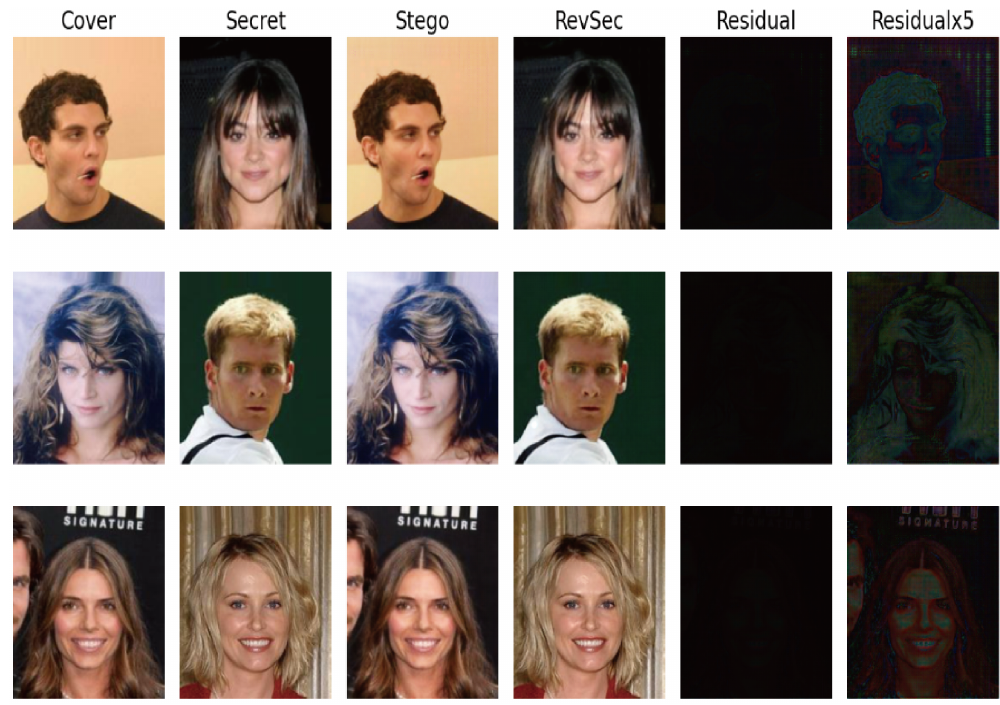
Figure 9. Test results of our proposed scheme on CelebA.